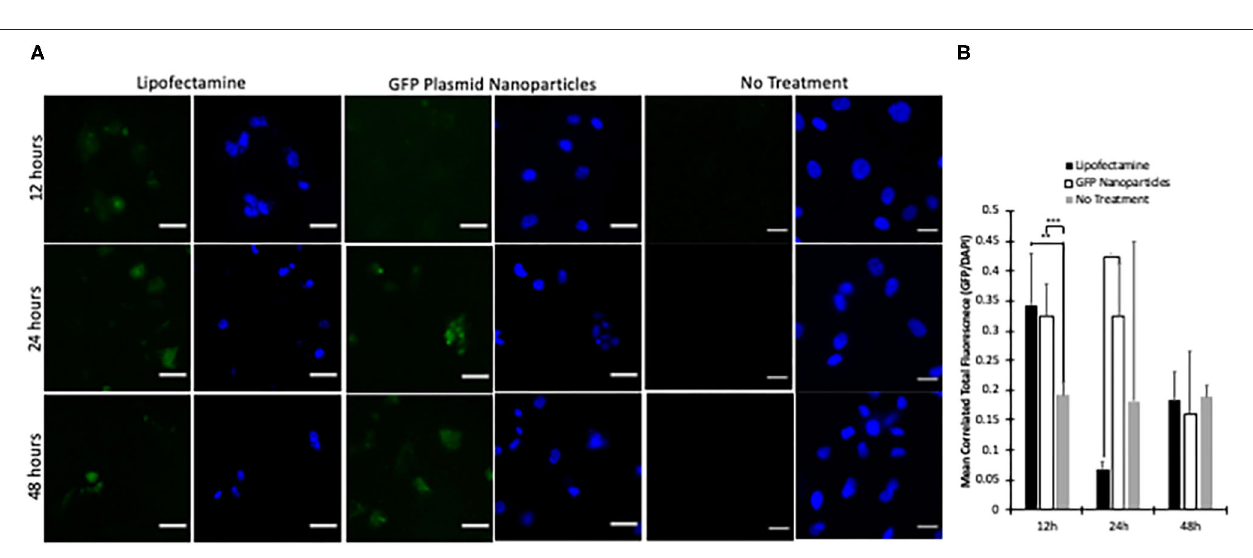
both lipofectamine treated and GFP plasmid-loaded nanoparticle treated groups ( Figure 6